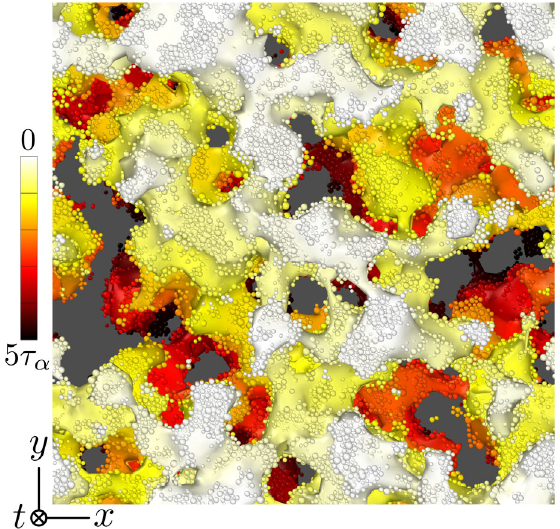
FIG. 19. Relaxation of very slow domains in the 2D model. x - y projection of the space-time mobility trajectory shown in Fig. 16. The color code indicates, in a linear scale, the time at which particles become mobile for the first